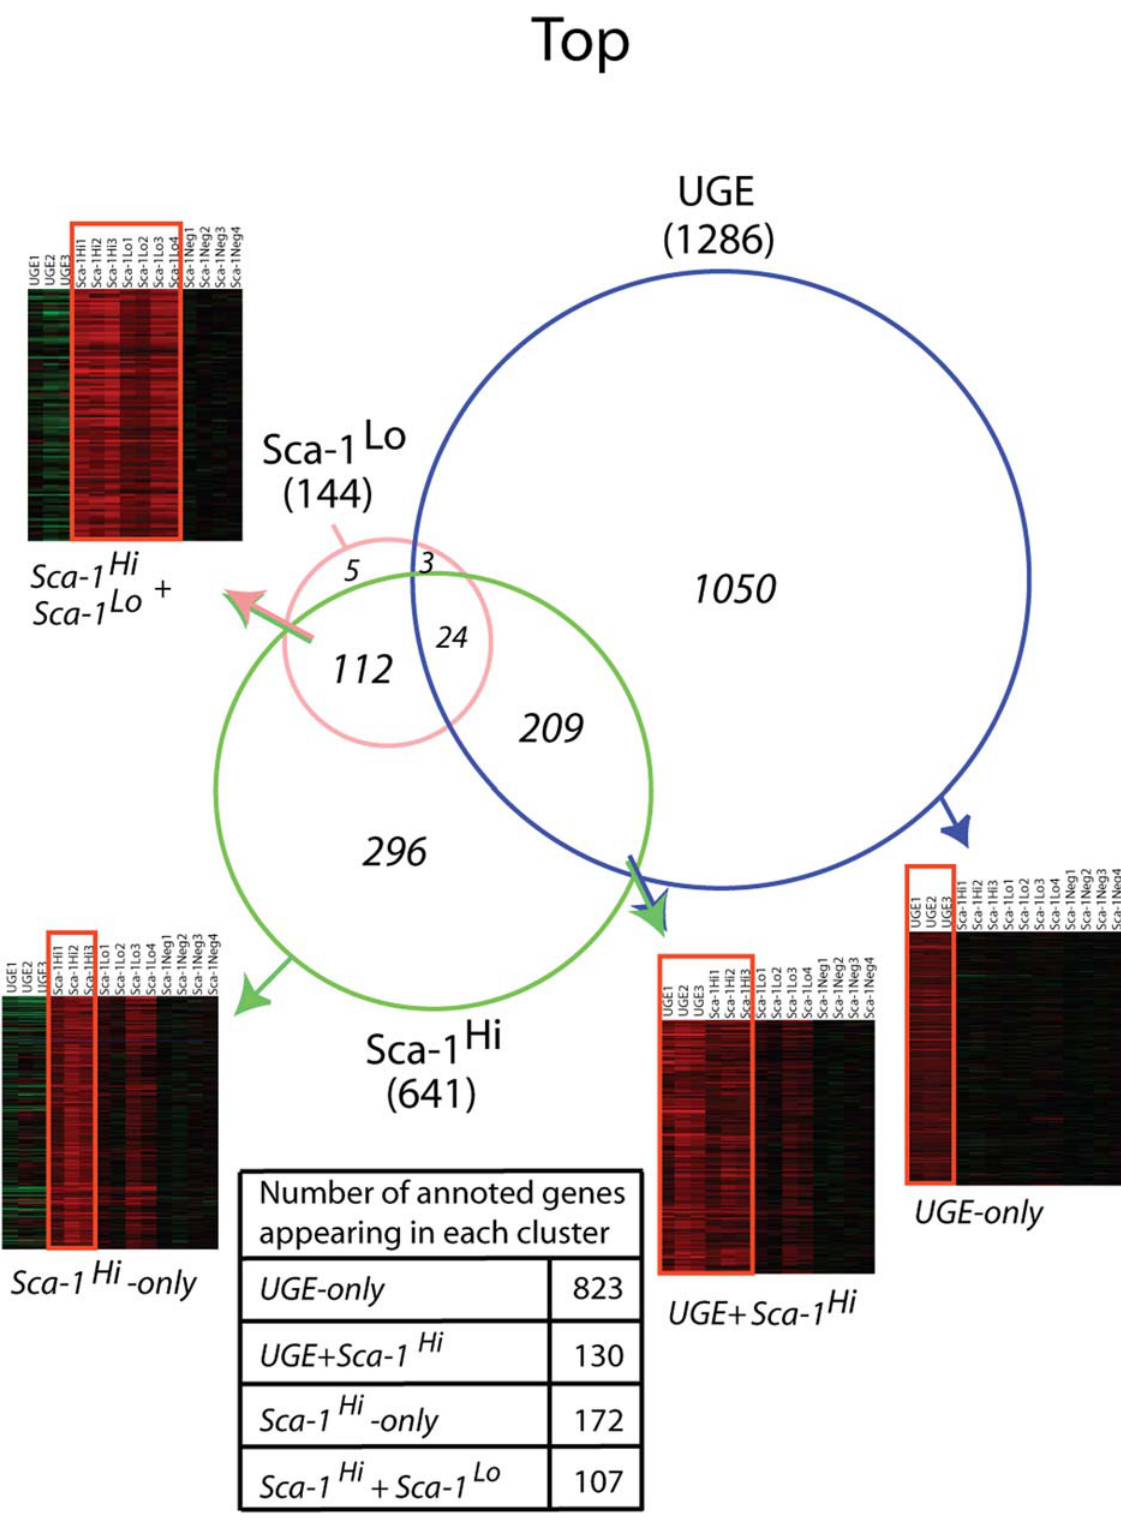
Figure 1. Overlapping gene expression in primitive prostate cell populations. A Venn diagram detailing the number of transcripts (gene probes) of overexpressed genes shared and distinct among UGE, Sca-1 Hi and Sca-1 Lo subsets. The number of transcripts within each subset is given in brackets outside the Venn chart. The number of transcripts within each cluster is given in Italics inside the slices of Venn chart. Numbers of annotated genes appearing in each of the four clusters are given in the inset table. The corresponding dendogram of each cluster is presented.